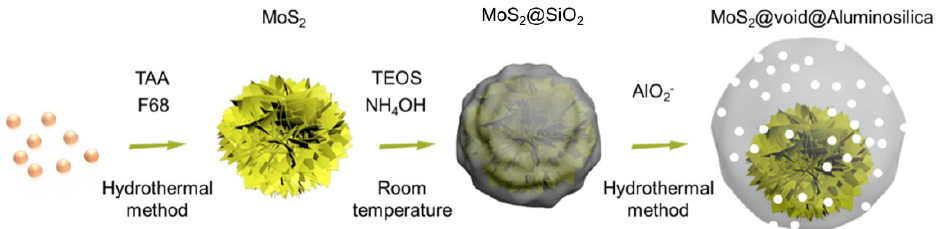
Figure 1. Schematic illustration for the synthesis of the MoS 2 @void@Aluminosilica microspheres.